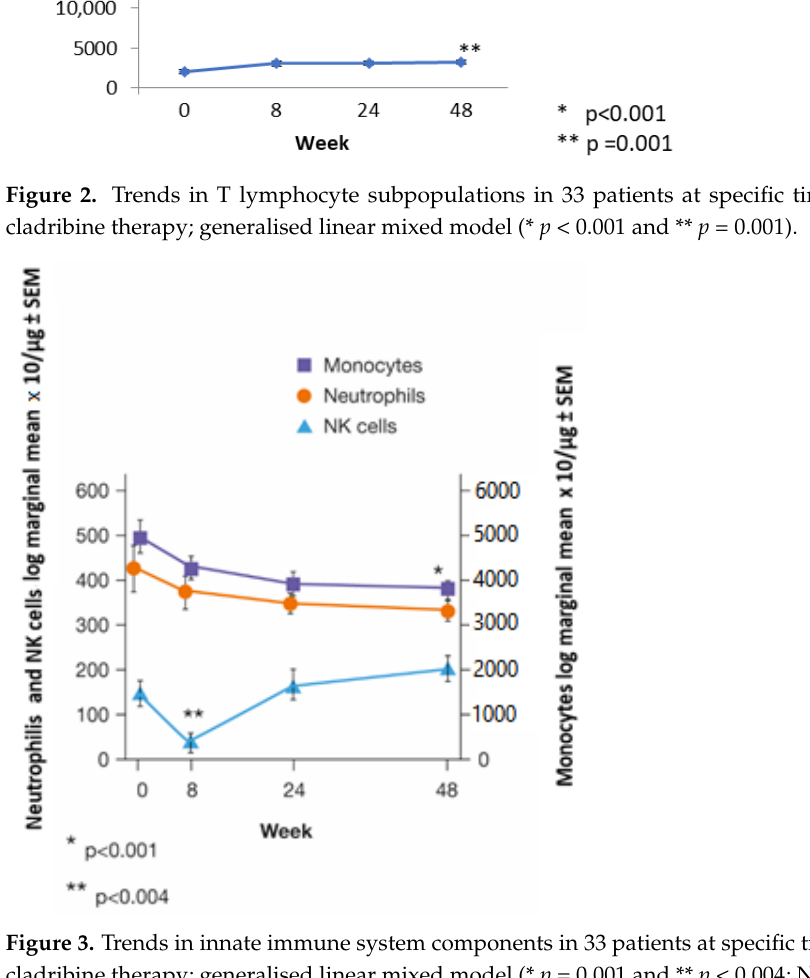
Figure 3. Trends in innate immune system components in 33 patients at specific times after starting cladribine therapy; generalised linear mixed model (* p = 0.001 and ** p < 0.004; NK = natural killer; SEM = standard error of the mean).